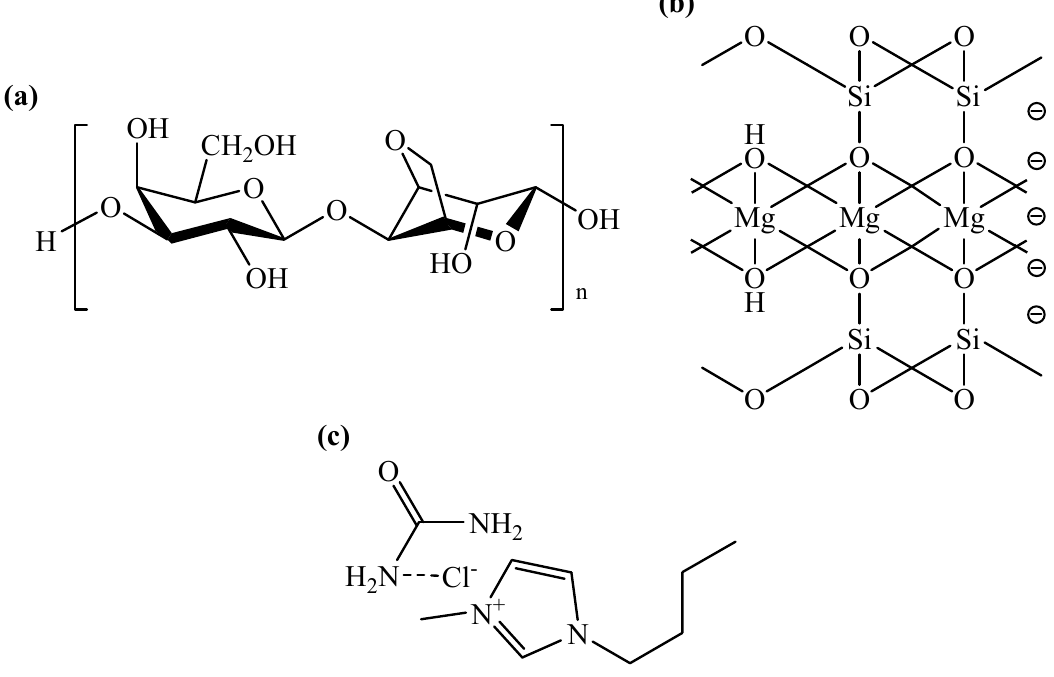
Figure 7. Chemical structures of the ( a ) agarose; ( b ) talc and ( c )